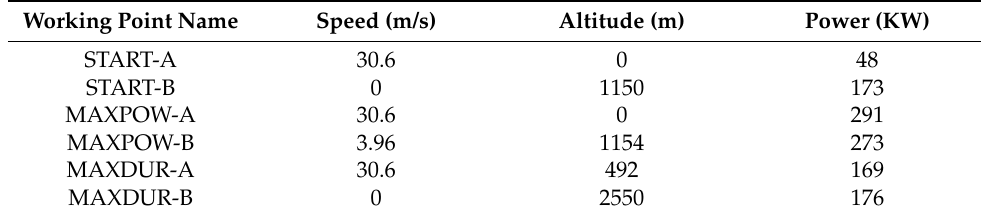
Table 3. Working point simulated in steady-state simulations.